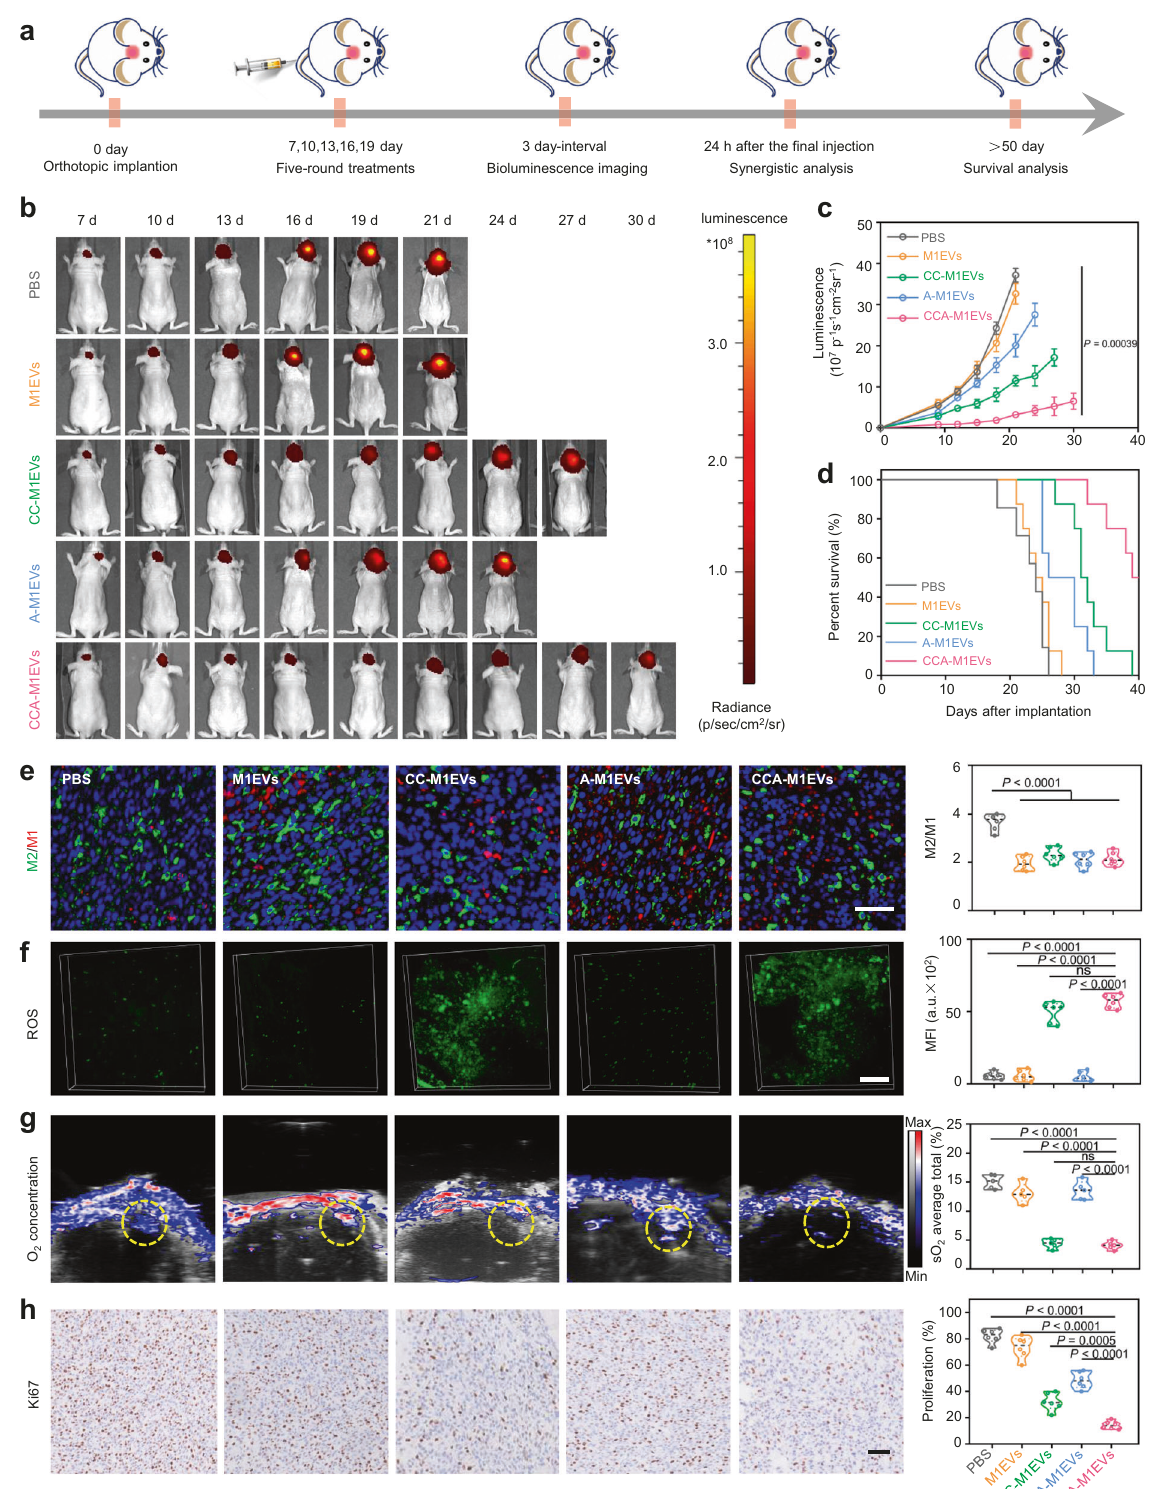
the PDT-associated restriction of the depth of light penetration. Although the ef fi cacy of this modality for the treatment of other solid tumors has been explored, it has not been found to be a silver bullet for the treatment of malignant GBM. In addition to aforementioned contact BBB, current dilemmas of using CDT for GBM therapy also include the inef fi cient intertumoral H 2 O 2 , and